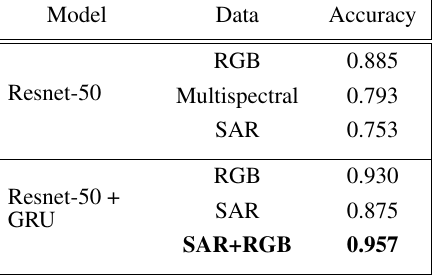
Table 1. First row : accuracy achieved by a state of the art network (Resnet-50) for a flood detection task on each image. Second row : accuracy given by a recurrent network on the sequence of image